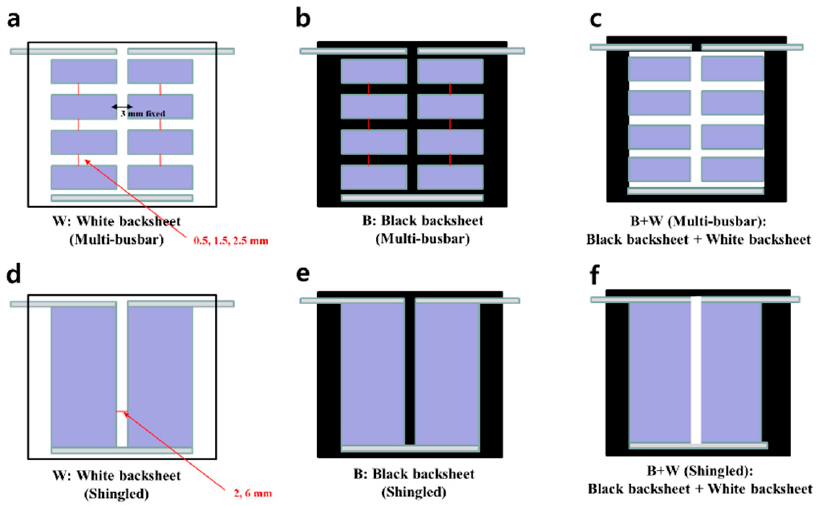
Figure 1. The illustrations of the fabricated MBB ( a – c ) and shingled ( d – f ) modules with white, black, and white–black hybrid-type backsheets.